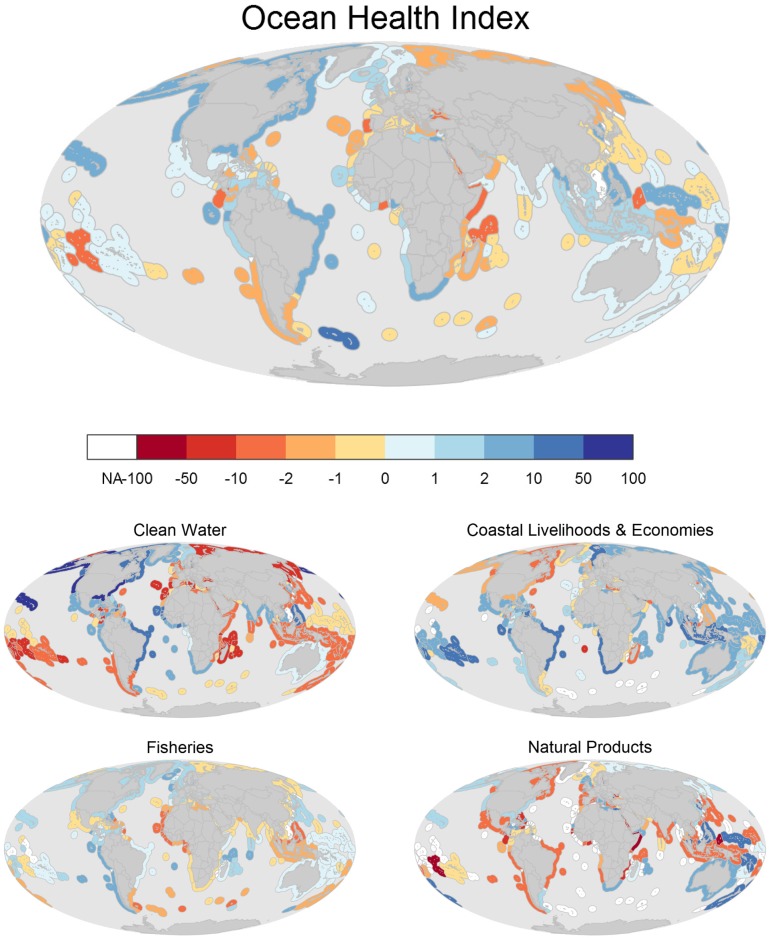
Change in Index and goal scores.Maps of the absolute difference of 2013 scores minus 2012 scores for each region for the overall Index (top panel) and four goals and sub-goals (bottom panels). Maps for all goals and sub-goals are presented in Figs. A-B in S1 File.